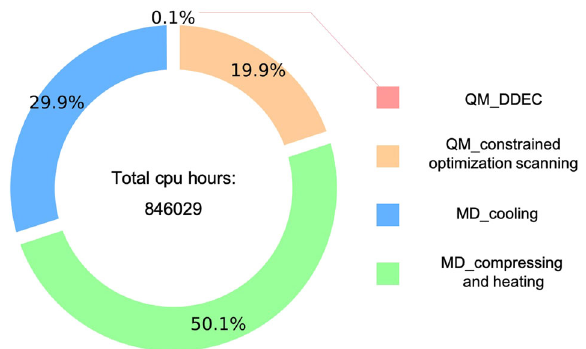
Fig. 5 Summary of the computational cost of our T g protocol. Pie chart of the computational costs (in terms of cpu hours) of different steps summed over all compounds in our